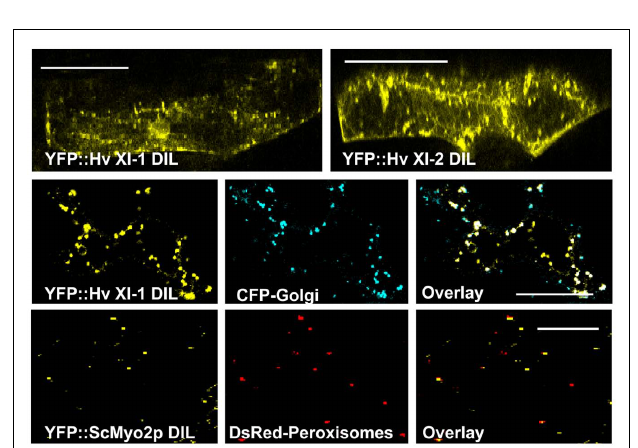
FIGURE 6 |Transient expression ofYFP:: Hv XI-1 DIL andYFP:: Hv XI-2 DIL in leaves of barley via particle bombardment. Co-expression of YFP::Hv XI-1 DIL domain with CFP markers for Golgi in epidermal leaf cells of N. benthamiana . Colocalization is shown in merged images ofYFP (yellow) and CFP (blue). Co-expression of theYFP::ScMyo2p DIL domain with DsRed markers for peroxisomes in epidermal leaf cells of N. benthamiana .The observed colocalization is shown in merged images of YFP (yellow) and DsRed (red). Scale bar = 50 μ